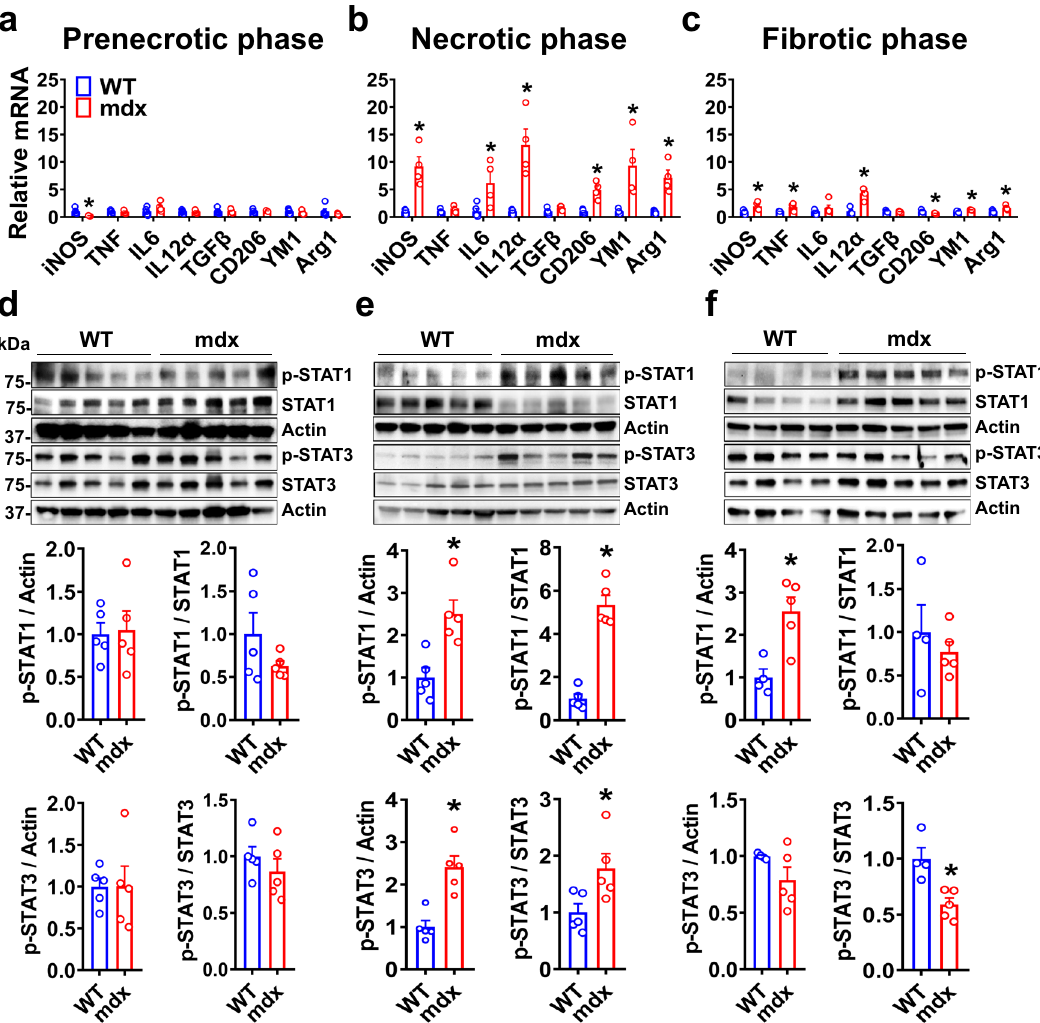
Fig. 1 Disease stage-dependent alterations in the basal in fl ammatory status of mdx BMDM. a – c The basal mRNA transcript levels (expressed relative to the mean age-matched WT level) of prototypical M1 (iNOS, TNF, IL6, and IL12 α ) and M2 (TGF β , CD206, YM1, and Arg1) marker genes during the: a prenecrotic ( n = 4 for iNOS, TNF, IL12 α , Arg1 genes in mdx; rest n = 5/group), b necrotic ( n = 5 for WT, n = 4 for mdx), and c fi brotic phases ( n = 4 for WT, n = 5 for mdx) of disease, are shown. The relative levels of phospho-STAT1, total STAT1, phospho-STAT3 and total STAT3 in cell lysates of WT and mdx BMDM from the same disease phases ( d – f , respectively; all experimental replicates are shown) are also demonstrated; d ( n = 5/group), e ( n = 5/ group), f ( n = 4 for WT, n = 5 for mdx). Data represent means ± SEM of biologically independent samples from different mice. * P < 0.05 vs. WT (unpaired t -test, two-tailed). See Source Data fi le for the exact P